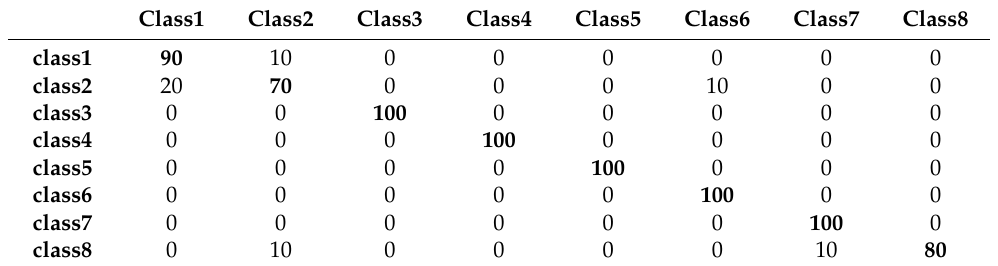
Table 7. Confusion matrix for KNN classification of the reconstructed patterns with a mega-dictionary.